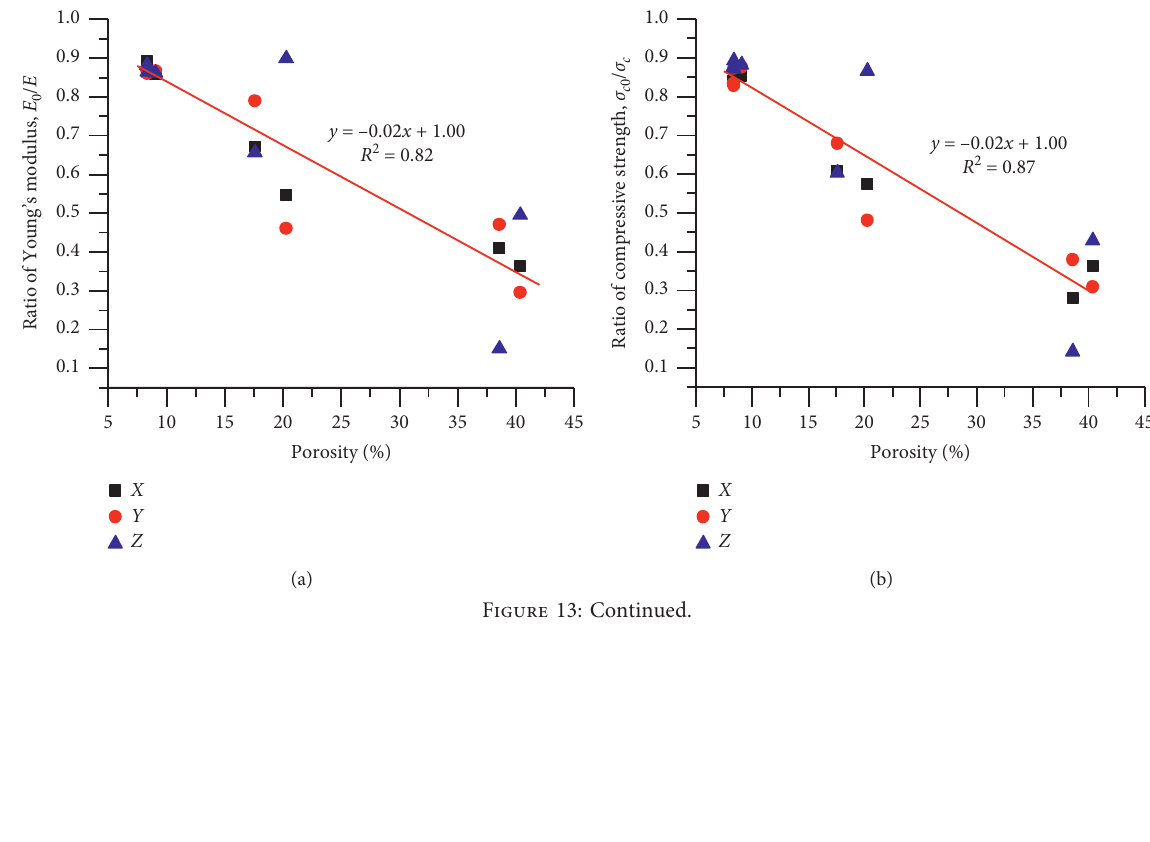
Figure 12: Stress-strain curves of digital rock samples. (a) ∼ (h) are the stress-strain curves of model S1, S2, S3, S4, S5 S5 400-2 . (a) φ � 17.6%. (b) φ � 20.3%. (c) φ � 38.6%. (d) φ � 40.4%. (e) φ � 8.36%. (f) φ � 9.07%. (g) φ � 8.3%. (h) φ �